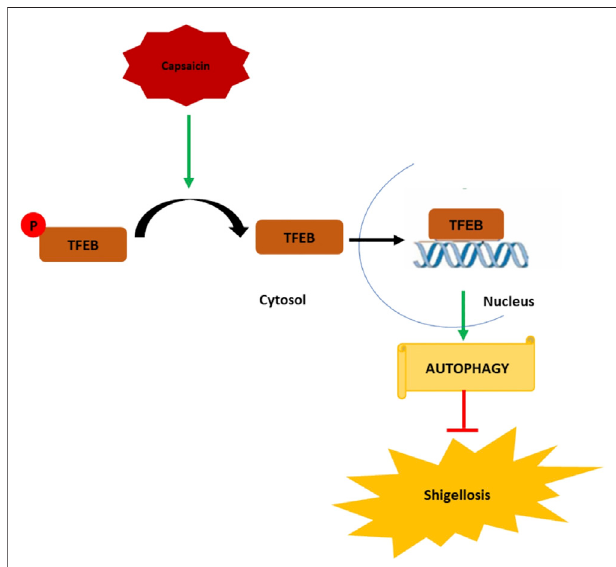
FIGURE 8 | Graphical representation of the mechanism of action of capsaicin (Caps). Caps inhibits TFEB phosphorylation. Dephosphorylated TFEB moves from cytosol to nucleus and binds to the promoter site of autophagy genes resulting in the upregulation of autophagy-associated marker genes. Induction of autophagy inhibits shigellosis by inhibiting S. fl exneri growth in both in vitro and in vivo models.